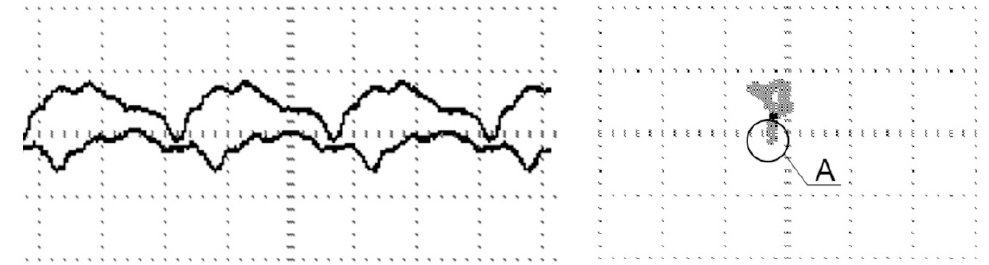
Figure 17. The signals ( left ) and the figure ( right ) from a pair of sensors with shift by π /2 for deflection { ∆ 1 = 0.00; ∆ 2 = − 0.03; ∆ 3 = − 0.015}: A—fragments caused by local inhomogeneity of the material.